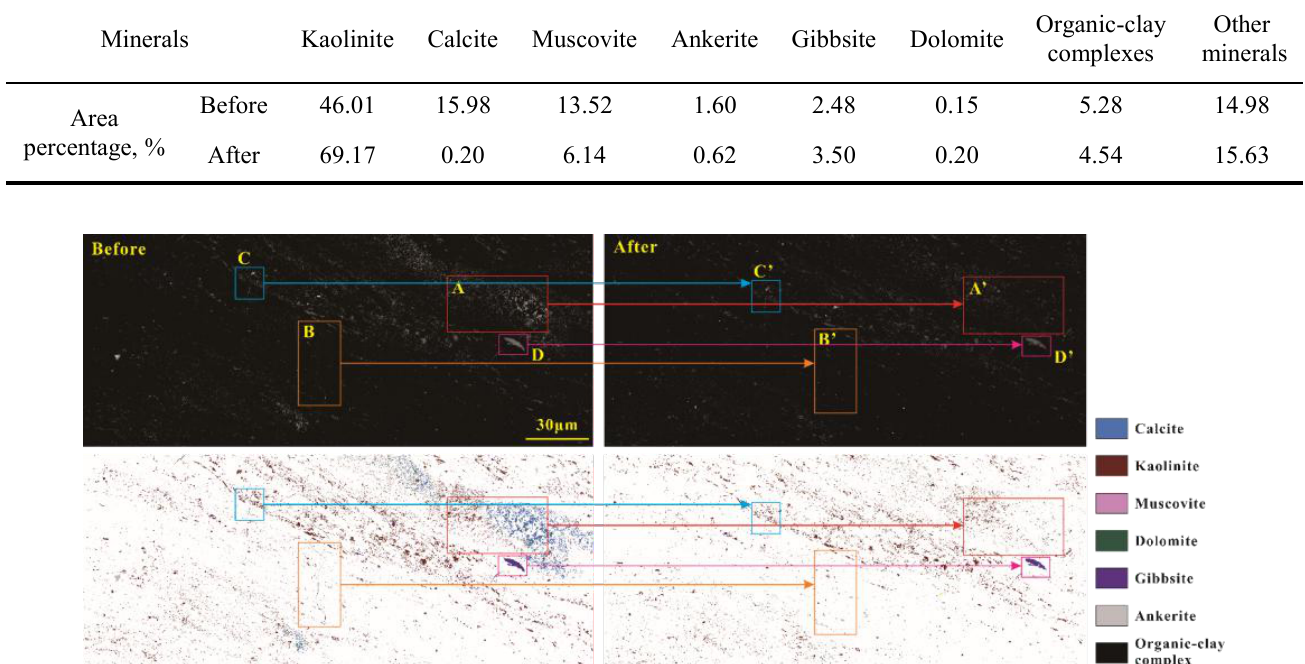
Table 4—Area percentages of minerals in Coal Sample #2 before and after CO 2 treatment.